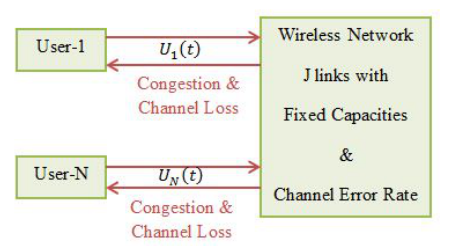
Fig. 6. Feedback control modeling: TCP over a wireless